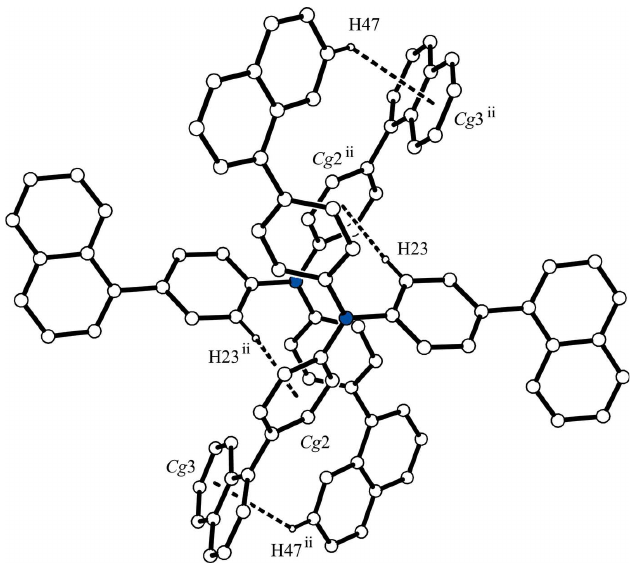
Figure 3 Another centrosymmetric dimer of the title compound. The C—H (cid:2)(cid:2)(cid:2) (cid:2) interactions are shown as dashed lines. H atoms not involved in the interactions have been omitted for clarity. [Symmetry code: (ii) (cid:3) x , (cid:3) y , (cid:3) z +